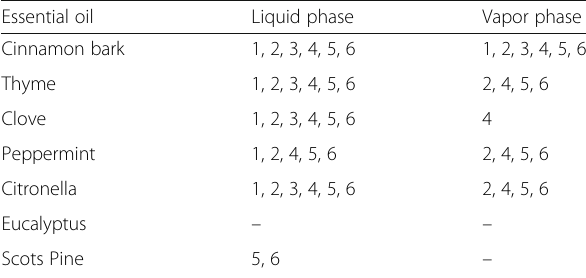
Table 6 Comparison of antibacterial activity of EOs in liquid and vapor phase